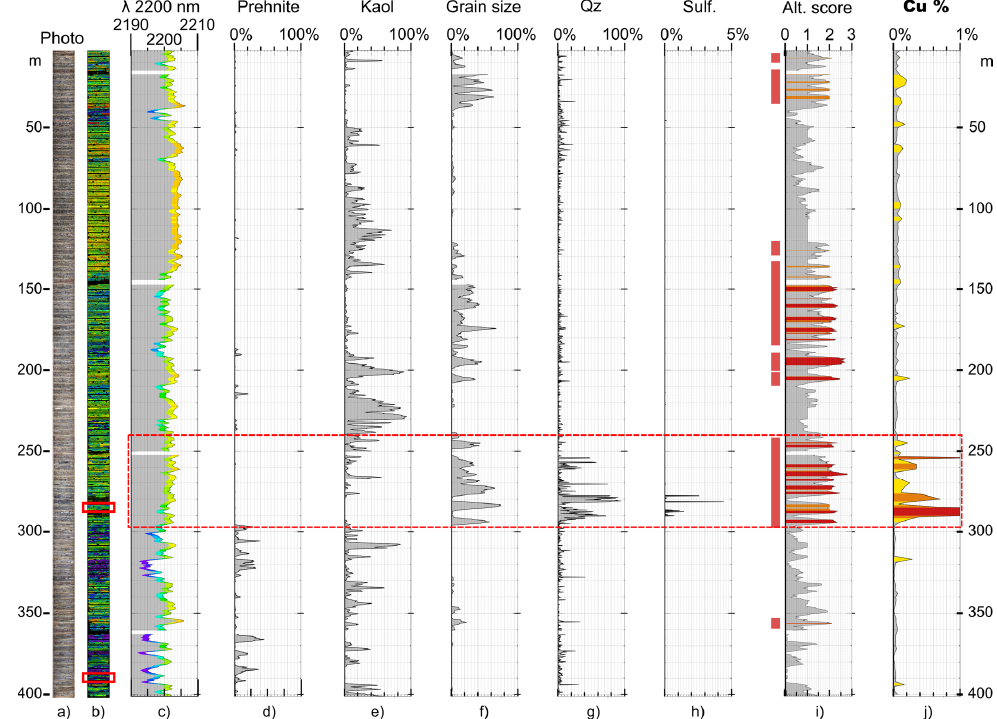
Figure 9 Figure 9. Downhole data from 400 m of drill core V15–021. ( a ) Stacked photographs of 111 core boxes. ( b ) Color-coded hyperspectral imagery displaying the position of the 2200 nm absorption feature (not filtered by mineralogy). The locations of boxes shown in Figure 10 are indicated. ( c ) Downhole graph of the 2200 nm absorption position, for every 20 cm interval of core, smoothed using a 2 m moving average. The following plots are smoothed downhole modal abundances of ( d ) prehnite; ( e ) kaolinite; ( f ) coarse-grained white mica, and non-smoothed modal abundances of ( g ) quartz; ( h ) sulfides; ( i ) spectral alteration score. Intervals of core with a score above 2 are shaded in red, and red outlines immediately to the left provide a 3 m bu ff er on either side of any altered zone. ( j ) Downhole Cu grade. The plot is capped at 1% Cu, with areas above this grade highlighted in red (the maximum grade is 2.1% Cu). Zones above 0.3% Cu are highlighted in orange, and zones above 0.1% Cu in